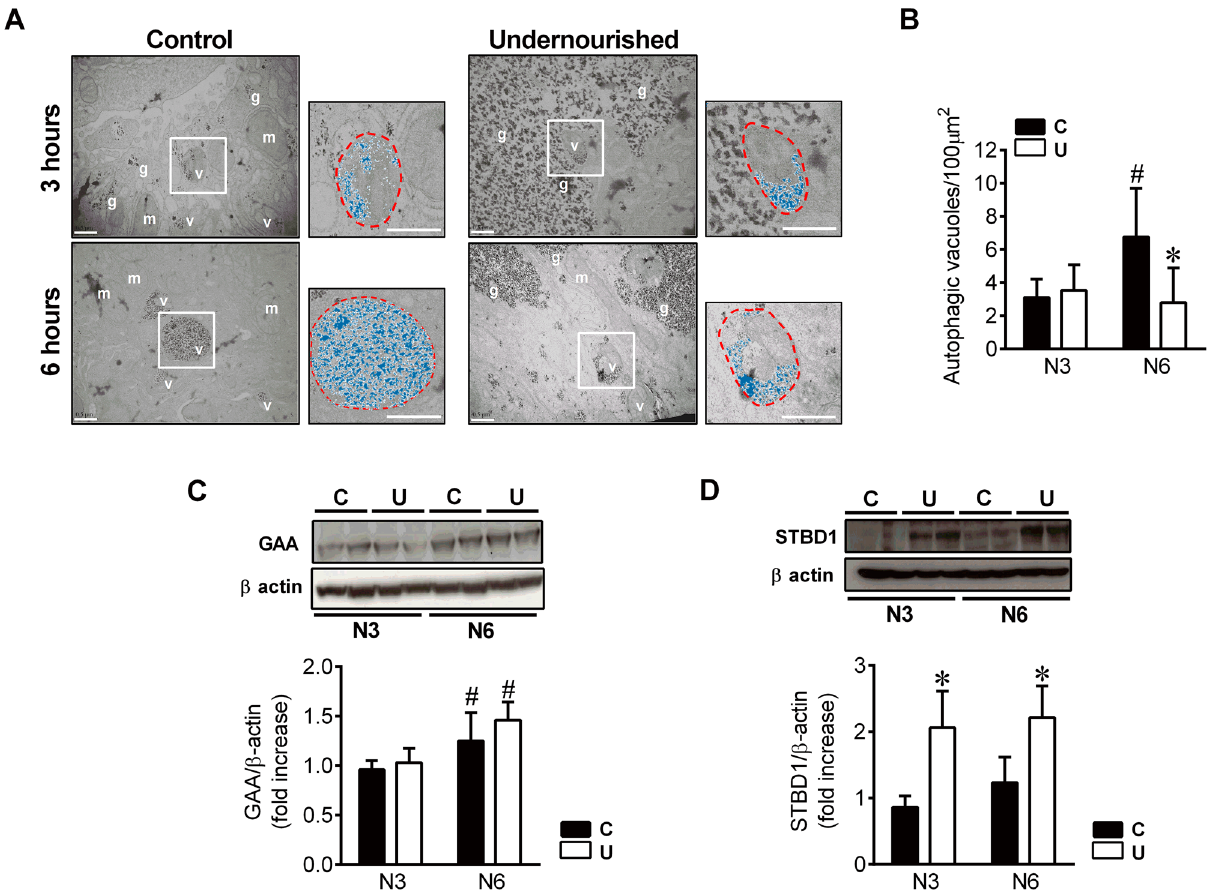
Figure 6. Reduced mobilization of glycogen into autophagic vacuoles in the liver of IUGR neonates. ( A ) Representative electron microscopy images after silver proteinate staining showing autophagosomes and autophagolysosomes in hepatocytes from C and U neonates at N3 and N6. Insets show higher magnification images of autophagic vacuoles with glycogen inside coloured digitally in blue. m: mitochondria, g: glycogen, v: autophagic vacuoles (scale bar, 500 nm). ( B ) Number of autophagic vacuoles per 100μm 2 of hepatic tissue quantified from 26 micrographs captured along a total cytoplasmic area of 1500μm 2 for each animal, n = 3–4. All values are mean ± SD. * p < 0.05 U versus C neonates at the same time point. # p < 0.05 N6 versus N3 within the same nutritional condition. Representative blots of 3 independent experiments (n = 6) of the protein levels of lysosomal alpha-glucosidase enzyme (GAA) ( C ) and starch binding domain protein 1 (Stbd1) ( D ) in liver homogenates from N3 and N6 neonates. Bars represent densitometric quantification of all blots relative to β-actin protein levels. All values are mean ± SD. * p < 0.05 U versus C neonates at the same time point. # p < 0.05 N6 versus N3 within the same nutritional